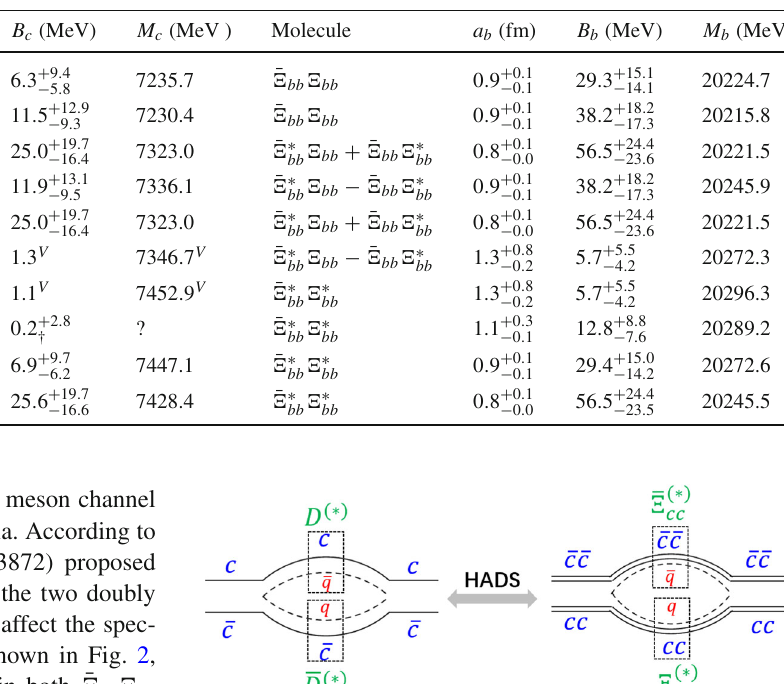
central value of the potential, and can become unbound if the poten- tial is made less attractive within the range specified in the text. The c and b subscript denote the charm and bottom sector, respectively. The uncertainties originate from the HADS breaking of the order 30%